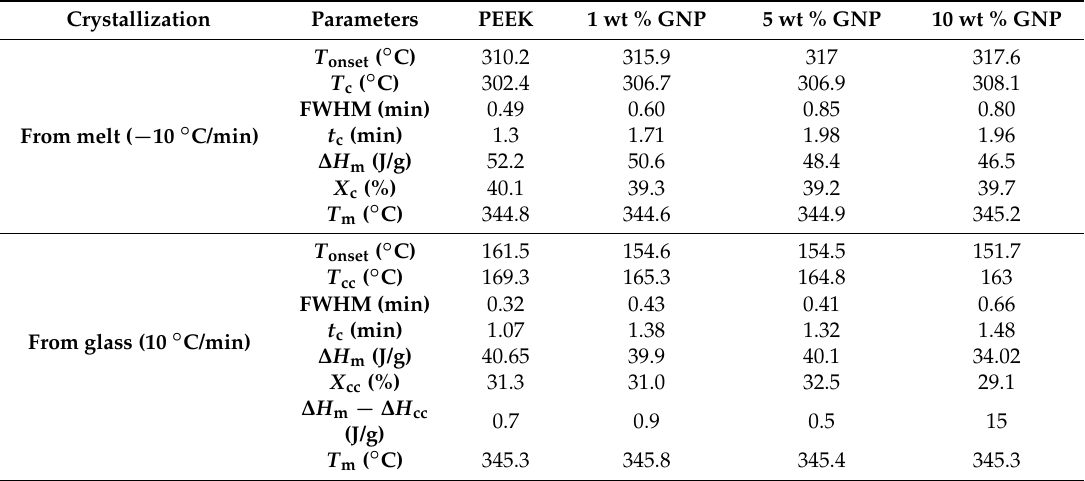
Figure 2. Differential scanning calorimetry (DSC) thermographs of poly ether ether ketone (PEEK) and PEEK with 1, 5, and 10 wt % of graphene nanoplateletets (GNP) during non-isothermal tests, ( a ) crystallization from melt, ( b ) subsequent melting, and ( c ) heating of quenched samples. Table 1. Temperature at the beginning of crystallization ( T onset ), crystallization temperature ( T c ), full width at half maximum value (FWHM) crystallization times calculated from T onset to T offset ( t c ), melting enthalpy ( ∆ H m ), degree of crystallization ( X c ), and melting temperature ( T m ) during non-isothermal crystallization from melt and glass state.